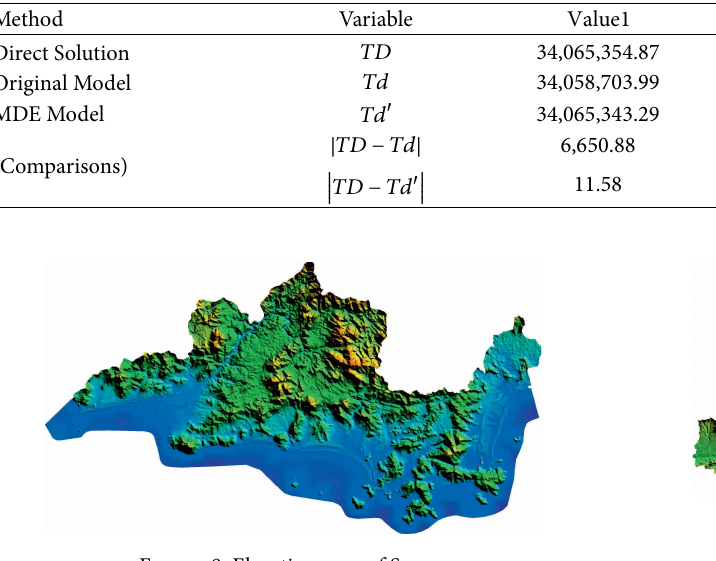
Figure 9: Elevation map of Sanya.